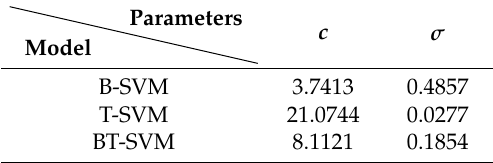
Table 5. Optimal parameters of SVMs with RBF kernel functions.